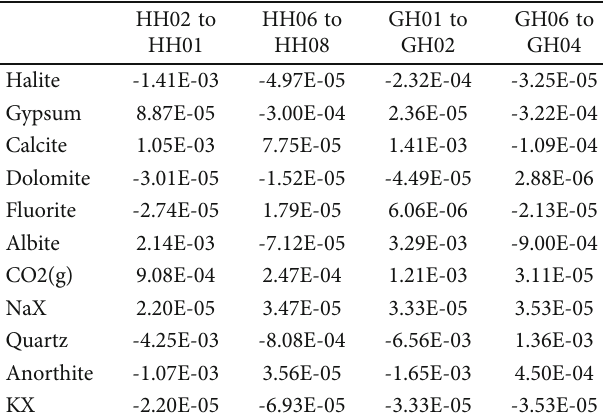
Table 3: Mole transfers simulated by PHREEQC